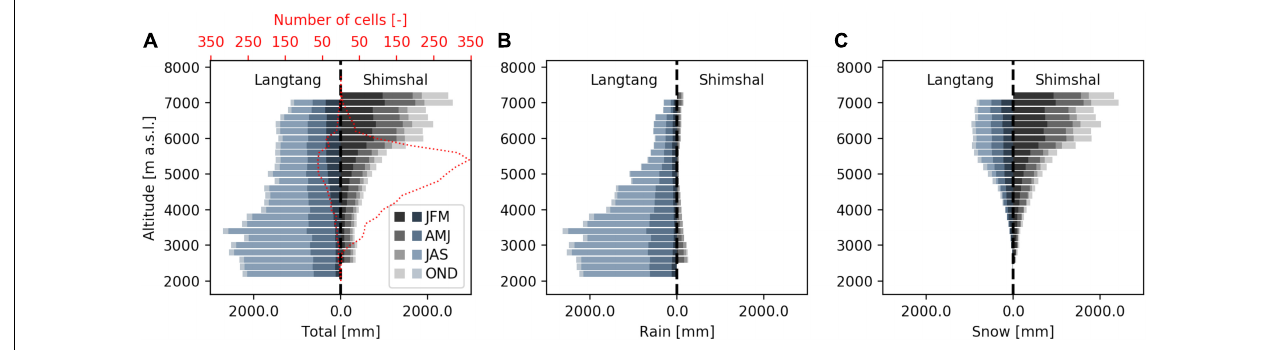
FIGURE 3 | Three-year seasonal average of precipitation (A) , rain (B) , and snow (C) by 200-m elevation bin. Each bin represents an average of all catchment cells in that altitude range. JFM is the period January, February, March, AMJ is the period April, May, June, JAS is the period July, August, September, and OND is the period October, November, December. The red dotted lines indicate the number of grid cells in each bin for the two catchments (A)